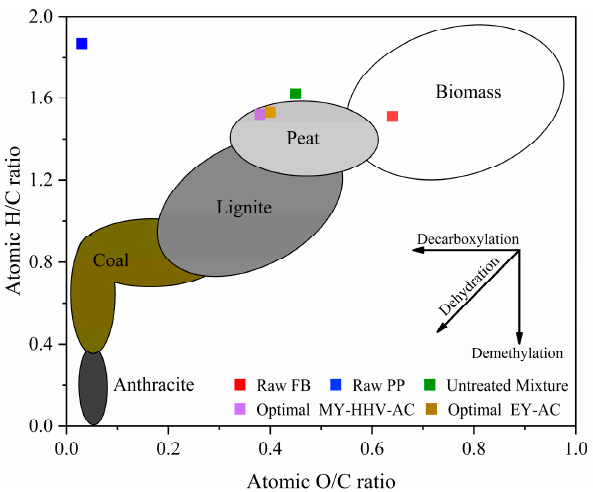
Figure 5. Van Krevelen diagram of H/C and O/C atomic ratios of the raw and optimal samples. The results of the elemental analysis of the untreated mixed raw sample and the two optimized sets of samples are shown in Figure 6. The optimized MY-HHV-AC set had the highest C content (60.45%) and the lowest O content (30.46%), whereas the optimized EY-AC set had a higher C content (59.26%) than the original blended mixture (56.73%) but a lower C content than the MY-HHV-AC set; additionally, the O content (31.7%) was lower than the blended original sample (34.22%) but higher than the MY-HHV-AC set, which is attributed to the thermal degradation of the volatile components, such as acids, alcohols, aldehydes, and oxygenated ketones, in the mixed biochar as the temperature increased [51]. In contrast, the H content remained stable, due to the low intensity of torrefaction (the optimized torrefaction temperatures of the two sets were 230.68 ◦ C and 220 ◦ C, respectively); similarly, the N content remained stable. However, the S content decreased with increasing torrefaction temperature, possibly due to the large amount of Ca in FB. FB biomass contains high Ca amounts. However, to remove miscellaneous bacteria while preparing the FB culture matrix, quicklime, whose major component is CaO, is added. While studying the cocombustion of plastics with printing and dyeing sludge, Ding [52] found that CaCO 3 in the plastic additive, as a calcium-based sulfur-fixing agent, chemically reacts with the sludge to generate CaSO 4 ; moreover, more S is fixed in the bottom slag to realize the self-desulfurization effect. The related chemical reactions are given by Equations (1) and (2).